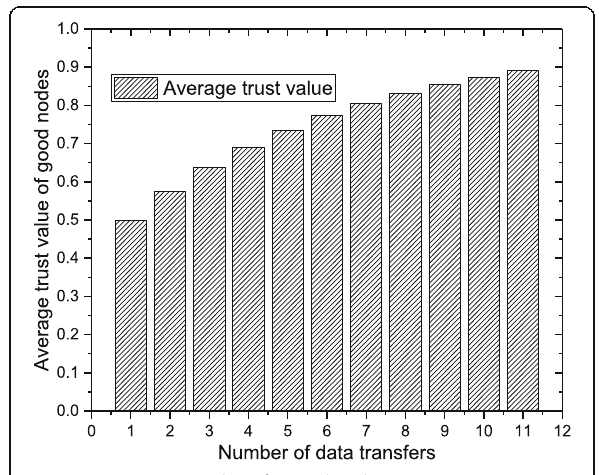
Fig. 10 Average trust value of trusted